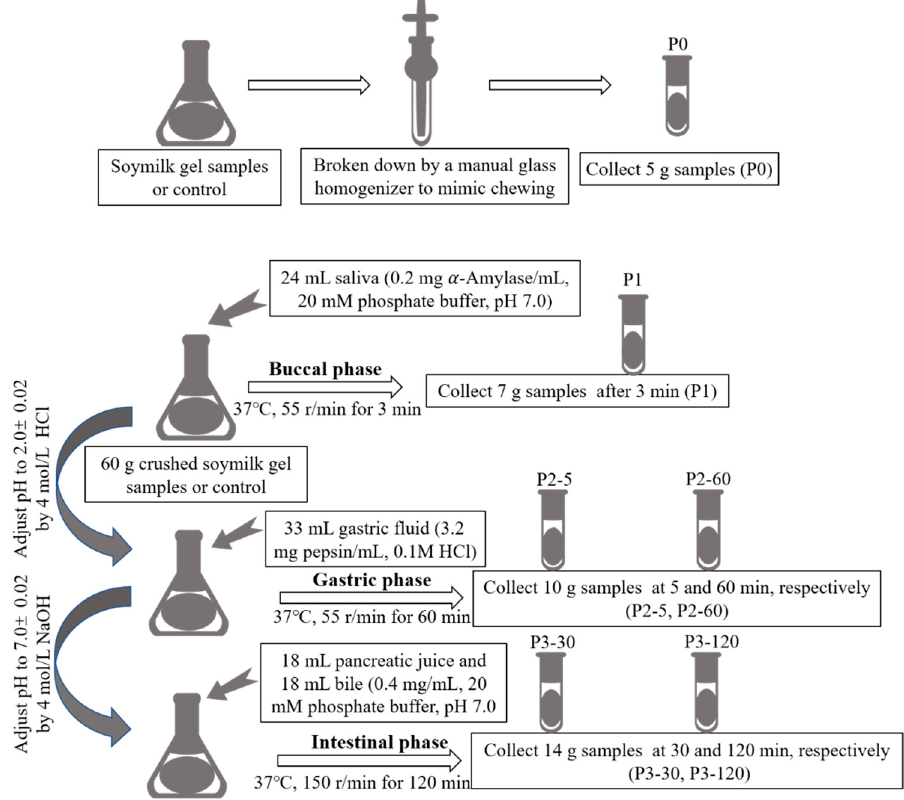
Figure 6. The whole in vitro GIS digestion